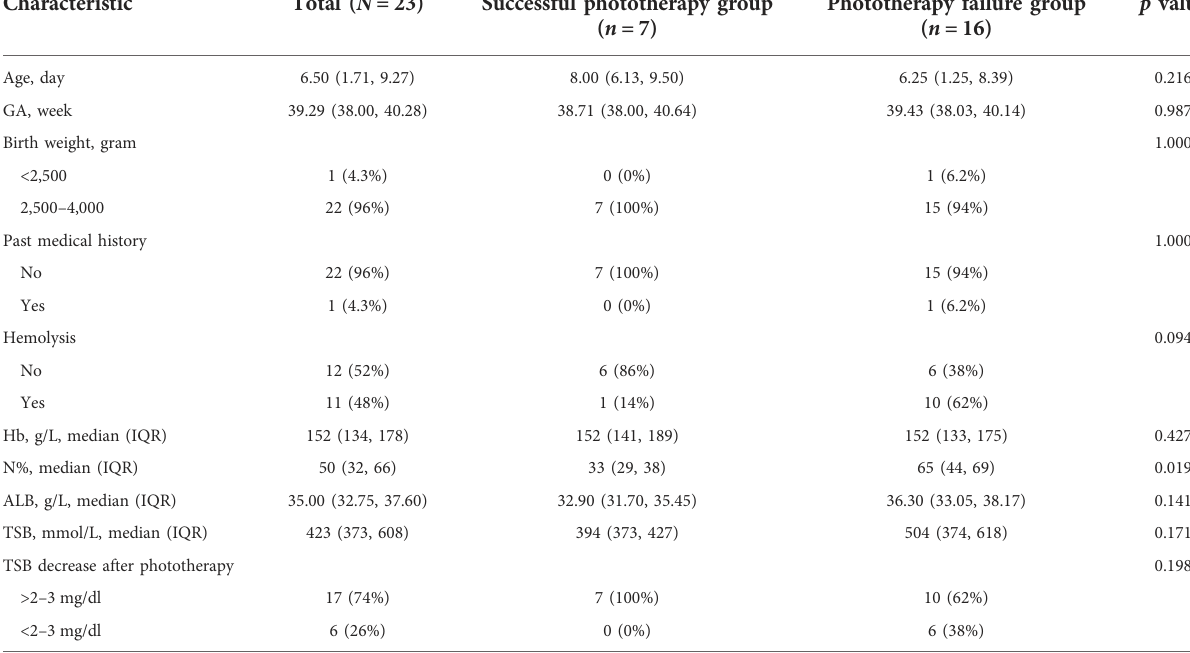
TABLE 3 Demographic and clinical characteristics of newborns in validation cohort: Suzhou Municipal Hospital ( N =23). Characteristic